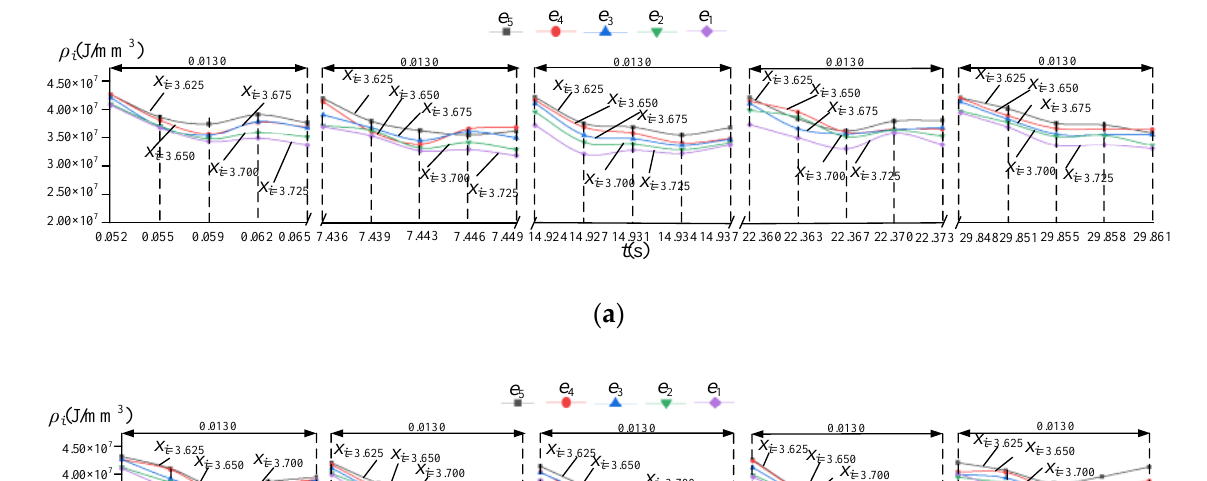
( c ) Figure 6. Finite element stress field distribution of the tool flank: ( a ) equivalent effect distribution; ( b ) temperature distribution; ( c ) wear depth distribution. Based on Table 1 and Figure 5, Equation (13) is used to solve for the instantaneous